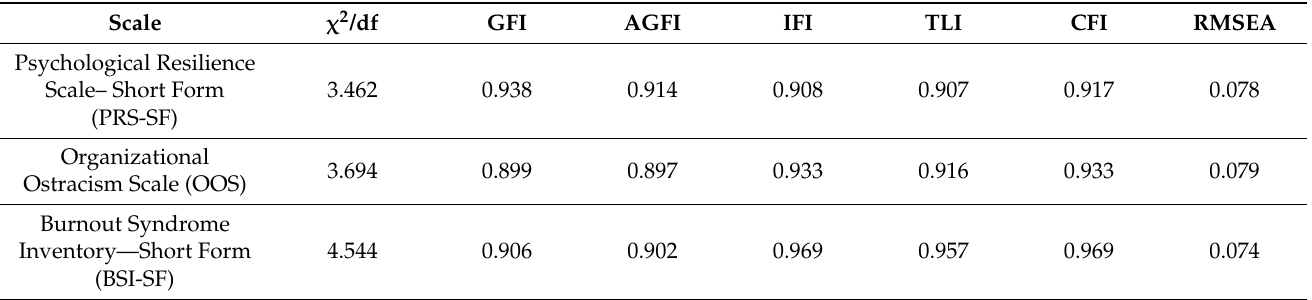
Table 7. CFA results of the